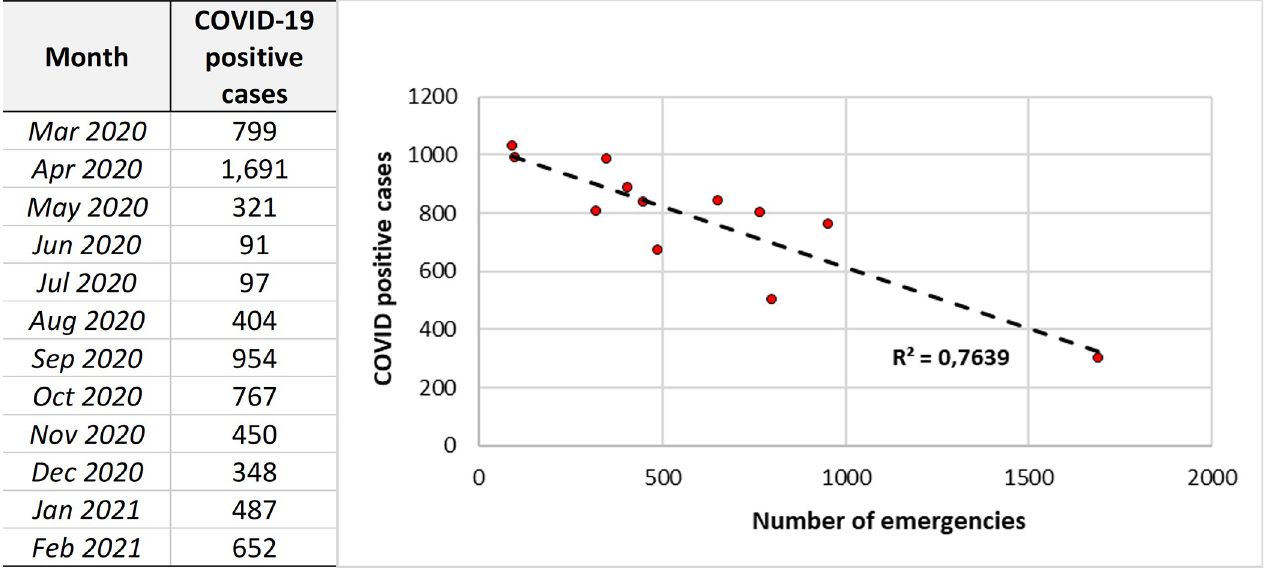
Fig 2. Regression analysis of the number of COVID-19-positive cases and the number of visits per month during the pandemic year.